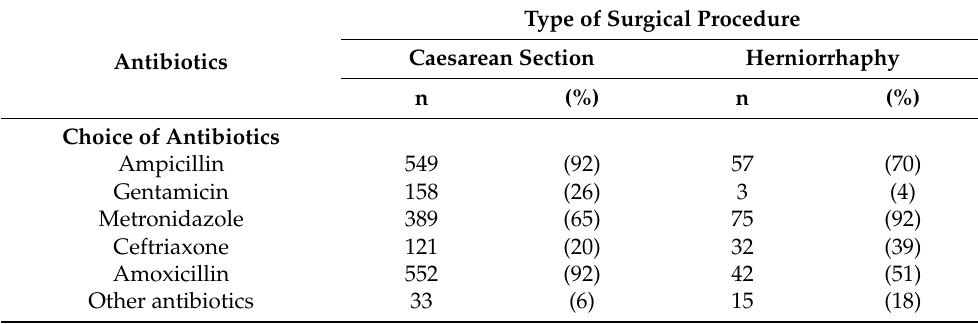
Table 2. Choice of antibiotics used in patients who underwent Caesarean section and herniorrhaphy surgeries at the Bo regional hospital, Sierra Leone, November 2019 to October 2020. Type of Surgical Antibiotics